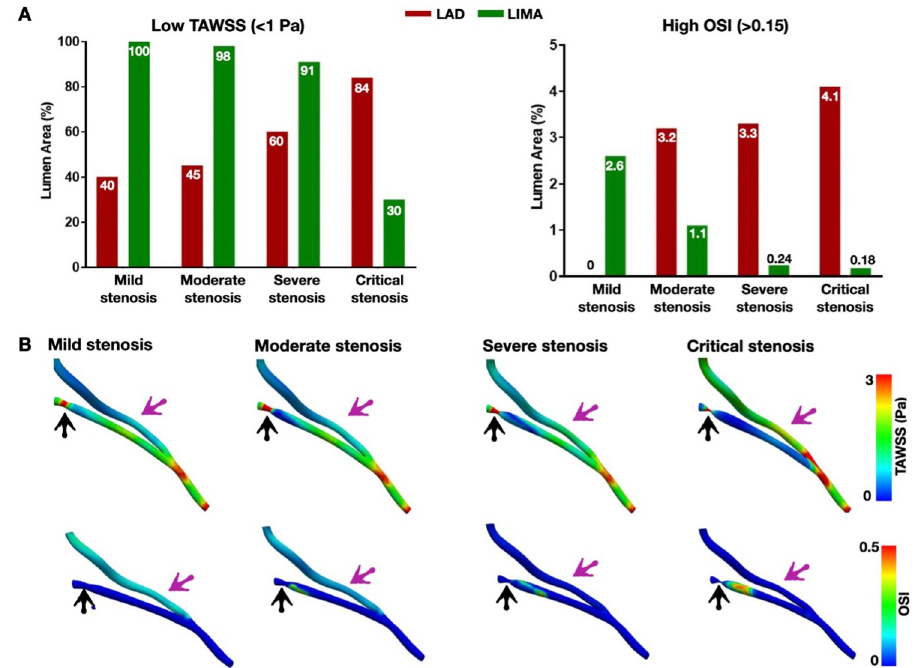
Fig 7. Representative example of low TAWSS and high OSI areas across the LAD and LIMA after CABG at resting conditions (Patient 3). A. Quantitative results, B. Qualitative results. Note that as the degree of LAD stenosis severity increases, the LIMA lumen area exposed to low TAWSS and high OSI decreases (A, green bars), whereas the LAD lumen area exposed to low TAWSS and high OSI increases (A, red bars). Values are expressed as mean ± SD (Purple arrow: LIMA, black arrow: LAD stenosis; LIMA: left internal mammary artery, LAD: left anterior descending artery, TAWSS: time-averaged wall shear stress, OSI: oscillatory shear index).